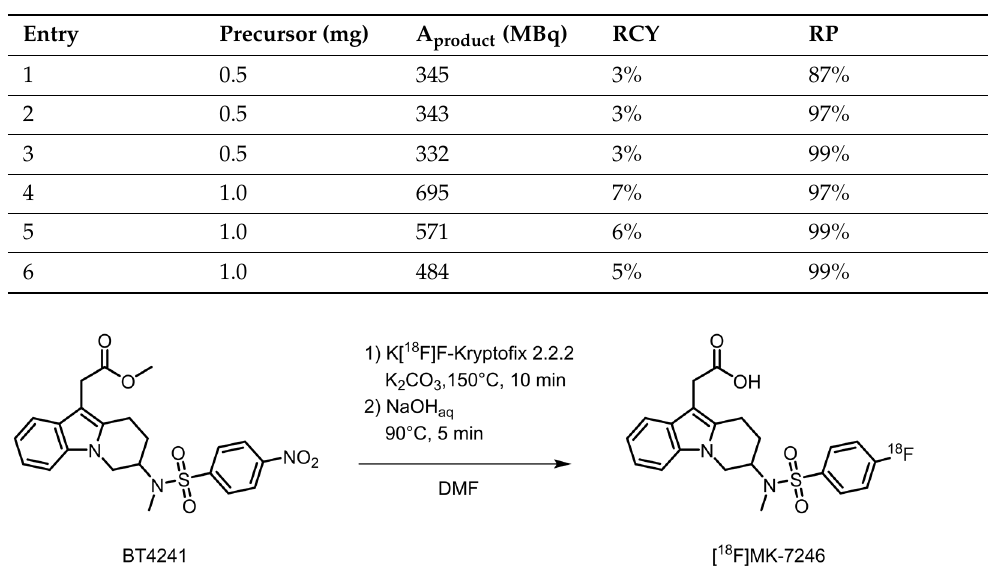
Figure 2. Synthesis of [ 18 F]MK-7246.